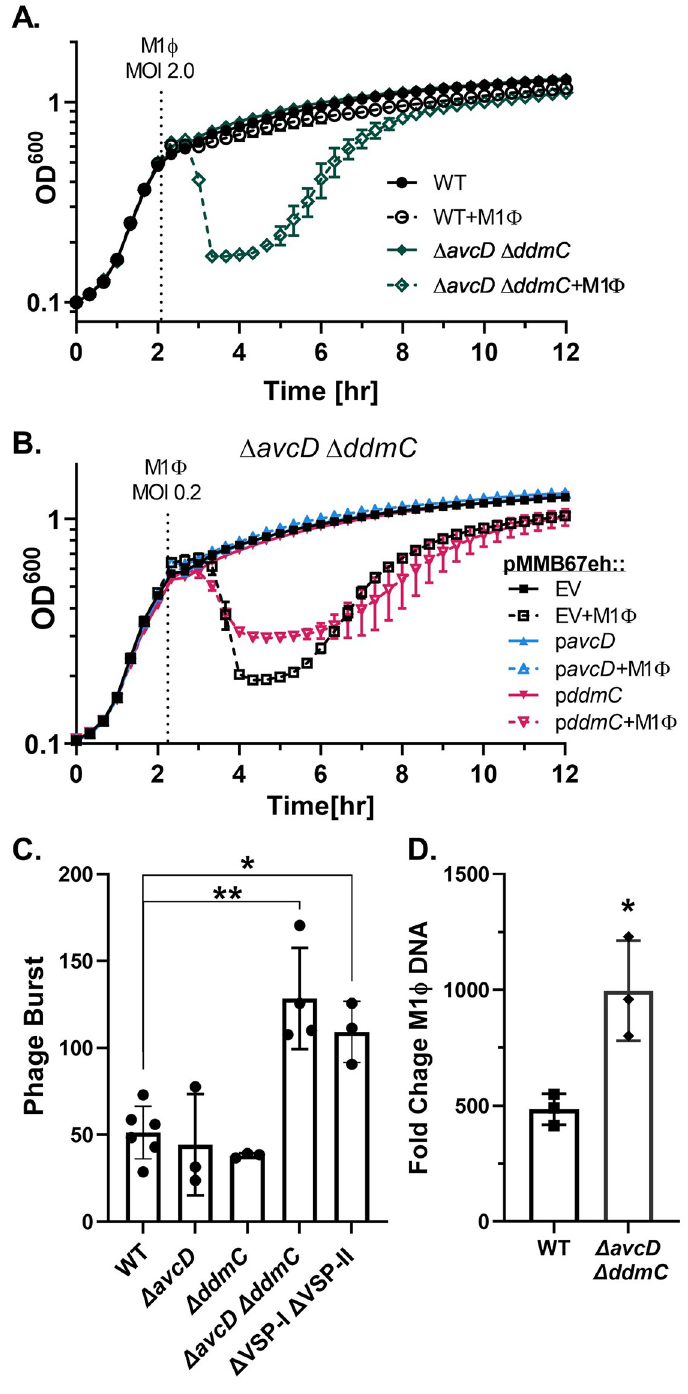
Fig 3. avcD and ddmC protect growing cultures of V . cholerae from M1 F infection. (A) Growth and lysis curves of V . cholerae . Indicated strains were infected with M1 F at an MOI of 2.0 at the time displayed by the dotted line. All strains were grown in LB shaking at 37˚C and optical density was read at regular intervals with a plate reader. (B) V . cholerae Δ avcD Δ ddmC strain containing the plasmid pMMB67eh or the same plasmid expressing avcD or ddmC was grown and infected with M1 F at an MOI of 0.2. (C) Phage burst assays. Strains were grown to mid-log phase before being infected with phage at an MOI of 0.1. After a period of absorption cultures were further diluted 1/2500,1/25000, and 1/250000. Burst is calculated by dividing the total output phage by absorbed phage (T0-T10). Strains are indicated on the x-axis. P-values were determined by Unpaired T-tests with Welch’s correction and significance shown